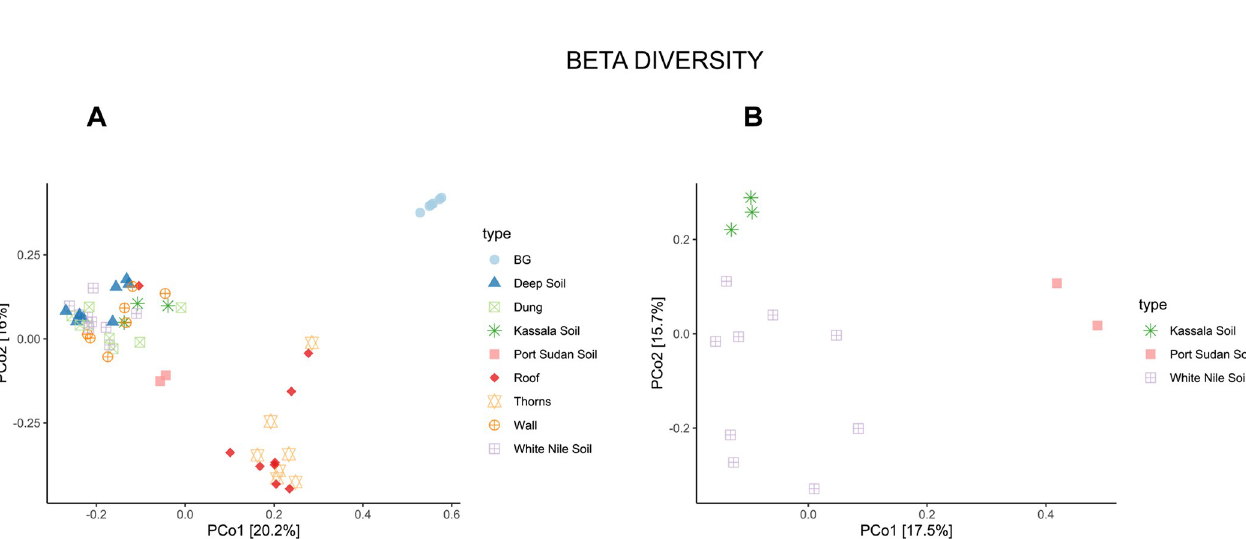
PLOS NeglectedTropical Diseases | https://doi.org/10.1371/journal.pntd.0010385 August 30,